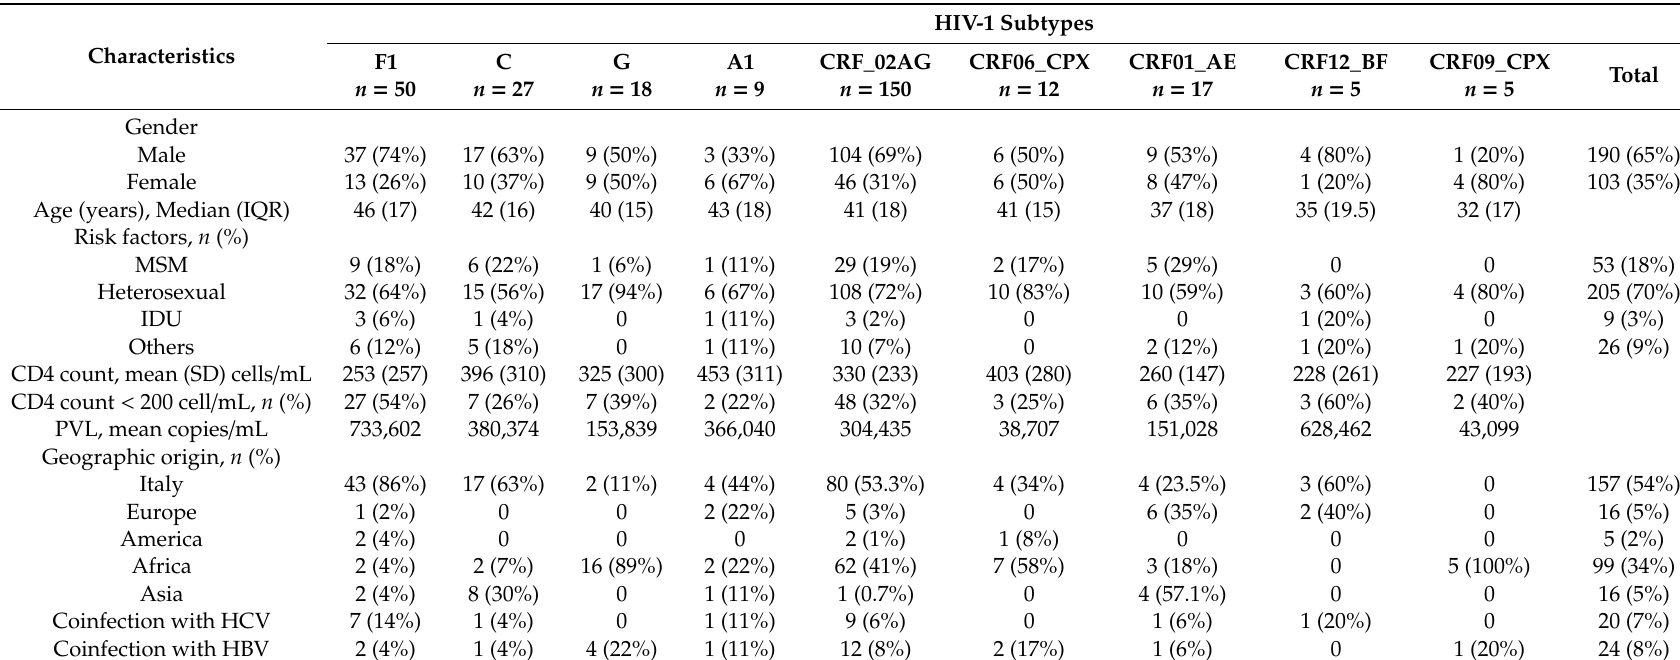
Table 1. Baseline characteristics of HIV-1 infected patients during the study period, according to di ff erent HIV-1 non-B subtypes.